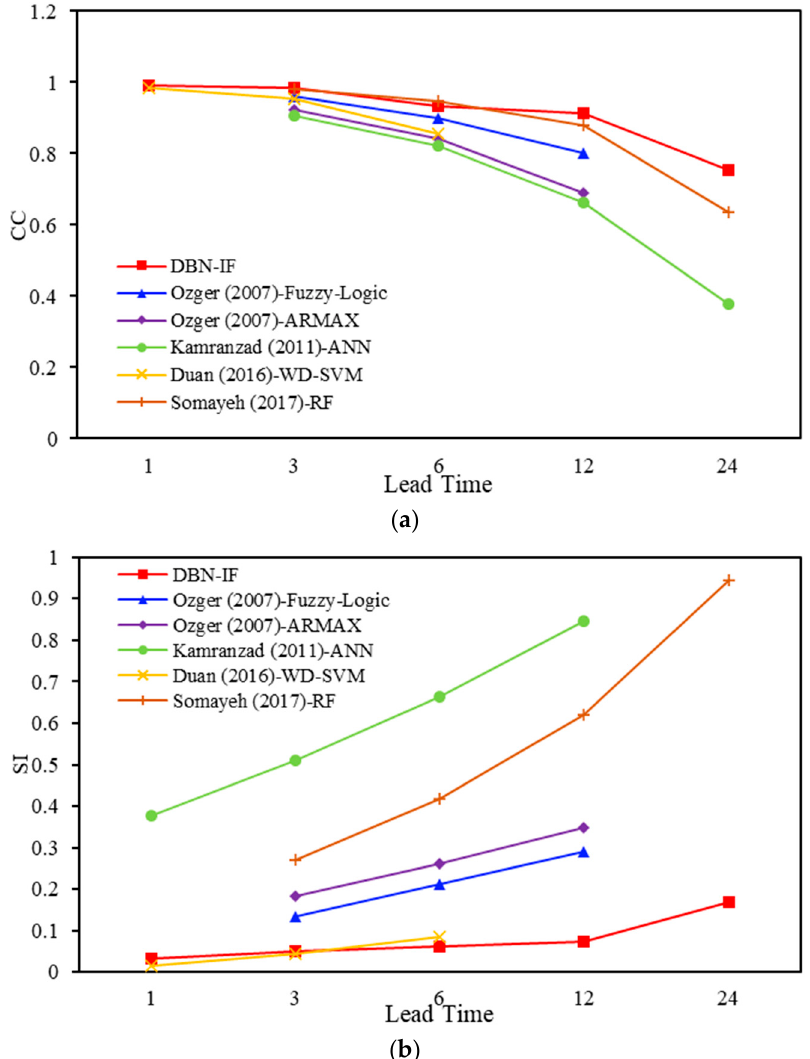
Figure 11. The CC and SI of different methods: ( a ) CC, ( b ) SI